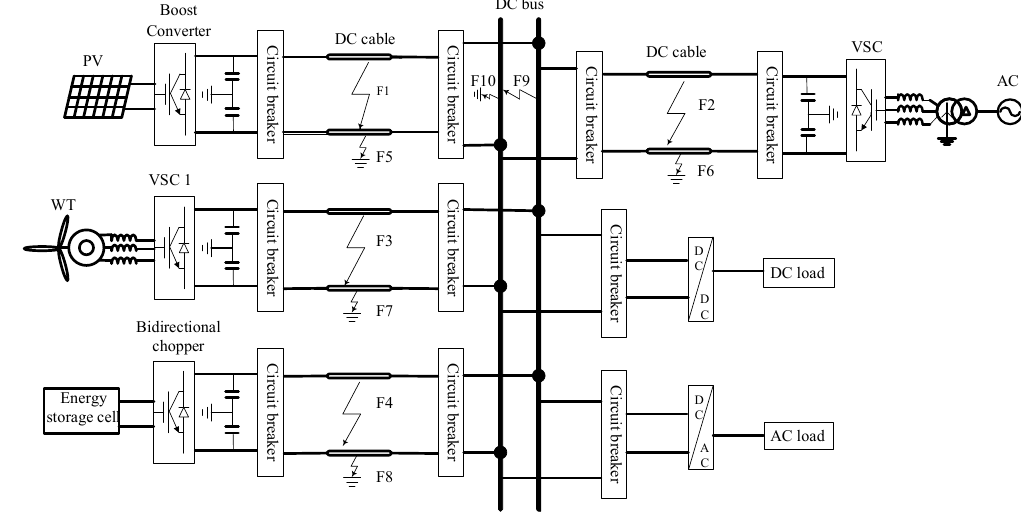
Figure 1. Structure of a LVDC distribution network.